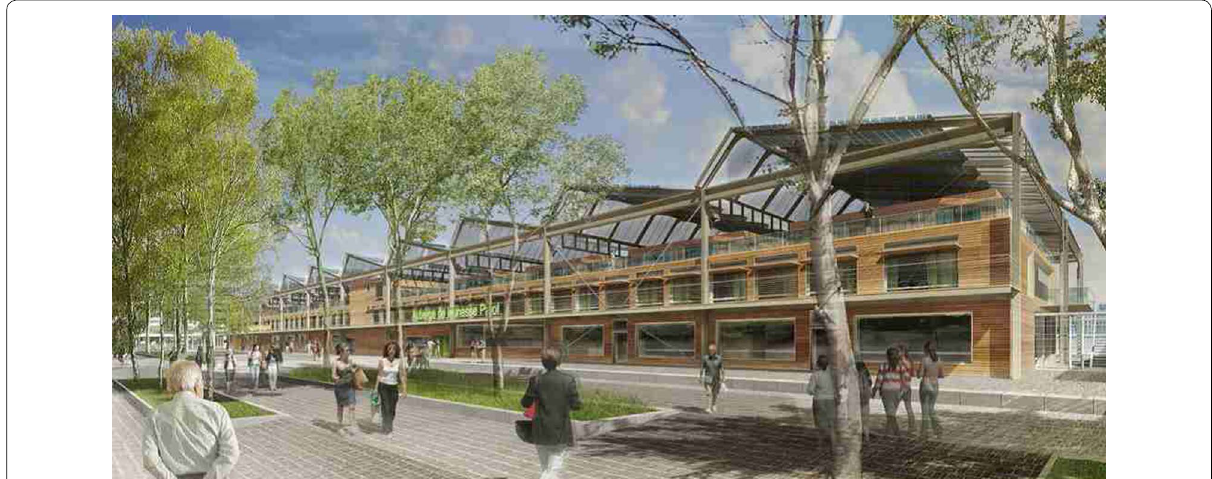
Fig. 8 Requalification of abandoned warehouse Halle Pajol, Paris (from http://www.jourd a-archi tecte s.com)